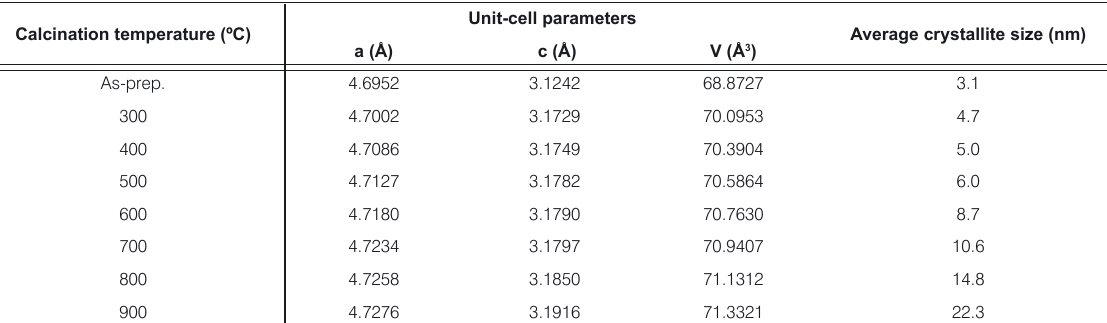
particles prepared by sol-gel method treated at different temperature. 2